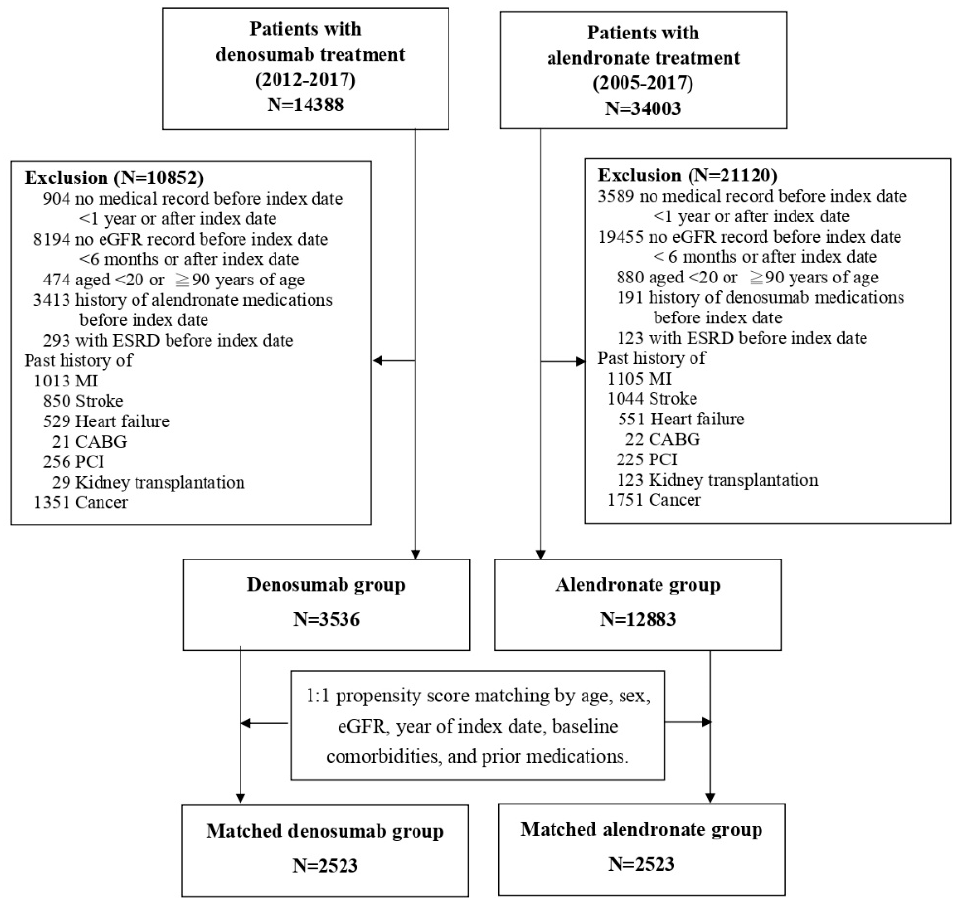
Figure 1. Study flowchart. Propensity score was calculated based on baseline comorbidities: